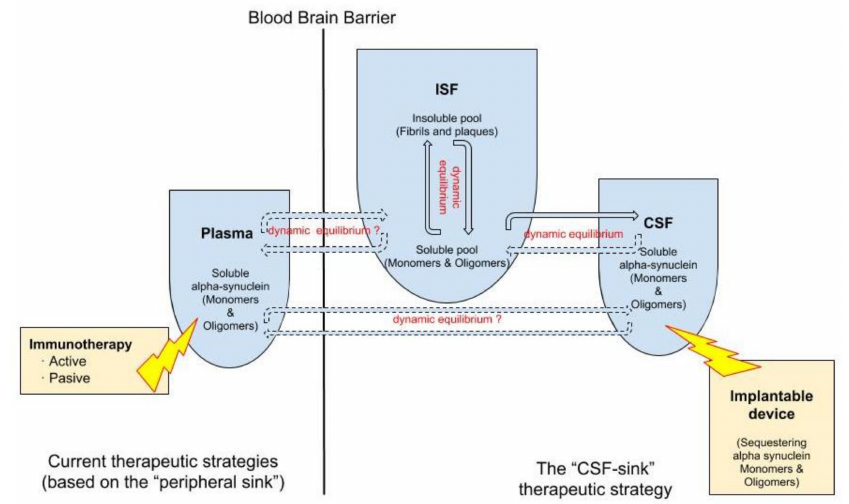
Figure 2. Double dynamic equilibrium of soluble α -Syn: there is a bidirectional equilibrium between insoluble and soluble pools of soluble α -Syn in the interstitial fluid (ISF) and there is a second equilibrium, also probably bidirectional, of soluble α -Syn between the ISF and the cerebrospinal fluid (CSF). The “CSF sink therapeutic strategy” consists in sequestering target proteins from the CSF with implantable devices, thus inducing changes in the levels of these proteins in the